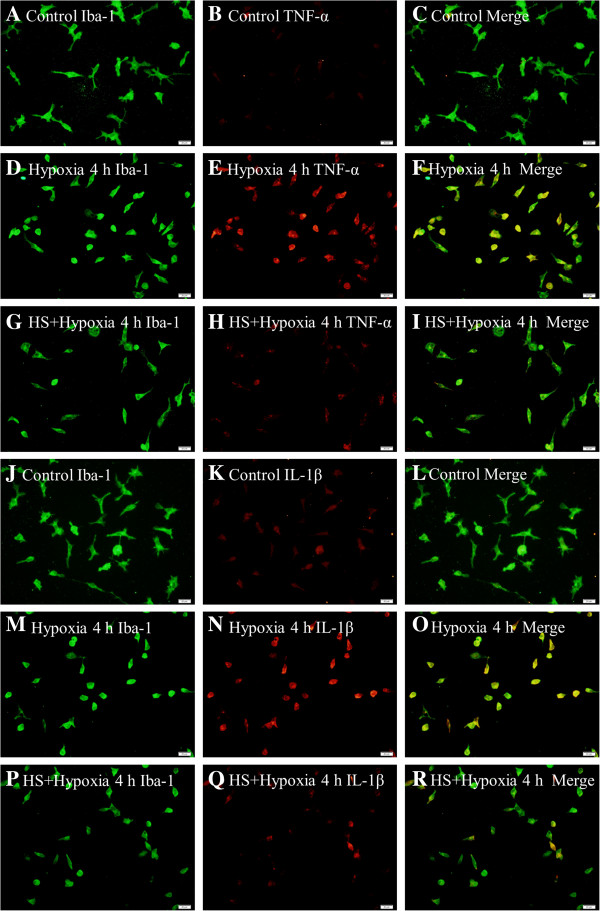
HS attenuated hypoxia-induced TNF-α and IL-1β expression in microglia. Immunofluorescence images of cultured microglia showing the expression of Iba-1 (A, D, G, J, M, P, green), TNF-α (B, E, H, red) and IL-1β (K, N, Q, red). The co-localized expression of Iba-1 and TNF-α can be seen in panels D, F, I. The co-localized expression of Iba-1 and IL-1β can be seen in panels L, O, R. Note that TNF-α and IL-1β expression are markedly down-regulated in microglia after treatment with 100 mM HS as compared with the hypoxia group cells. Scale bars: (A-R), 20 μm. HS, hypertonic saline; IL-1β, interleukin- 1beta; TNF-α, tumor necrosis factor-alpha.